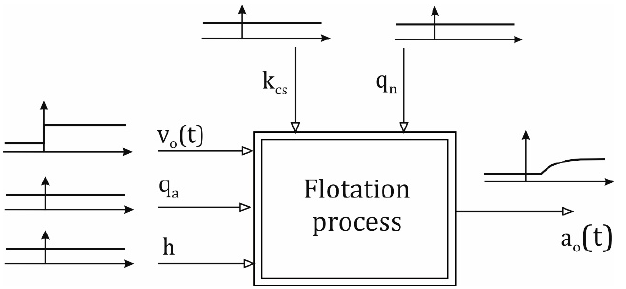
Figure 3. Identification of a dynamic model of the coal flotation process with the use of the step response method.